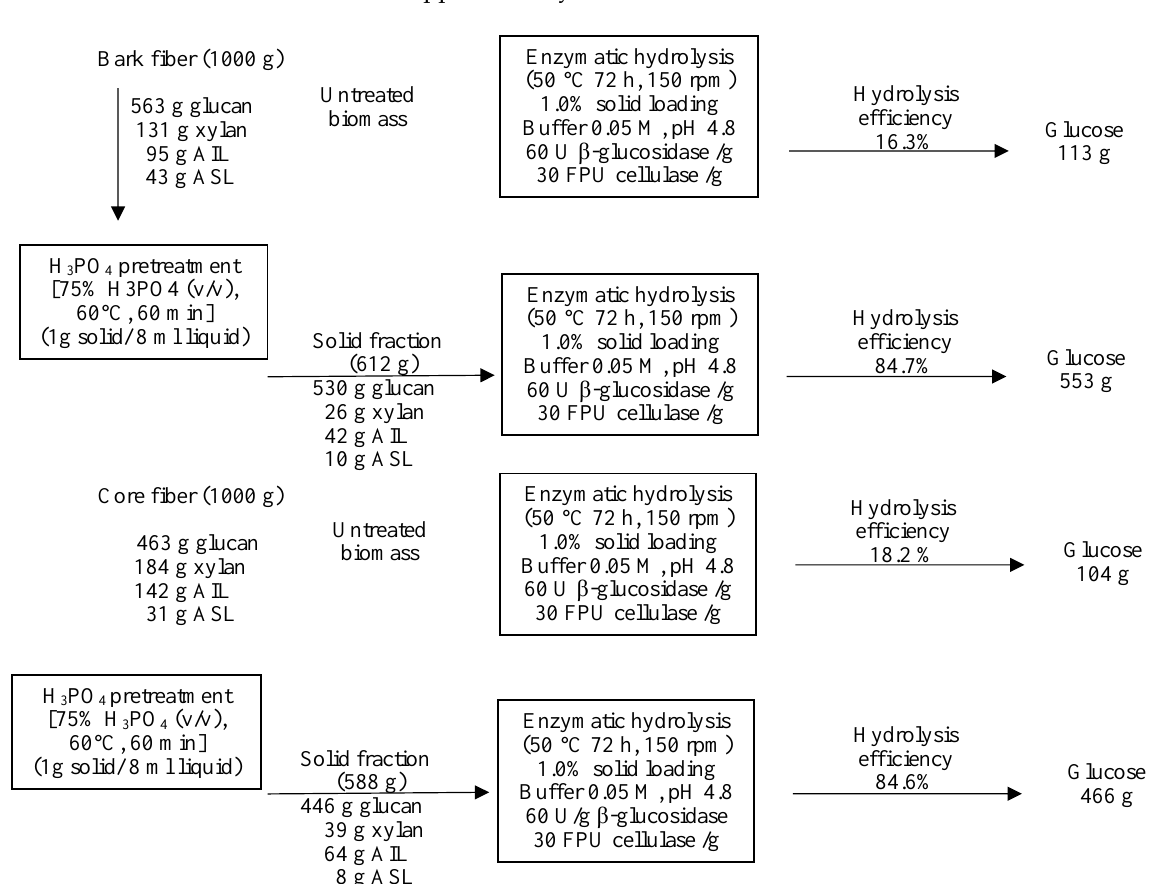
Figure 8. Material balance of bark and core fibers for glucose production.